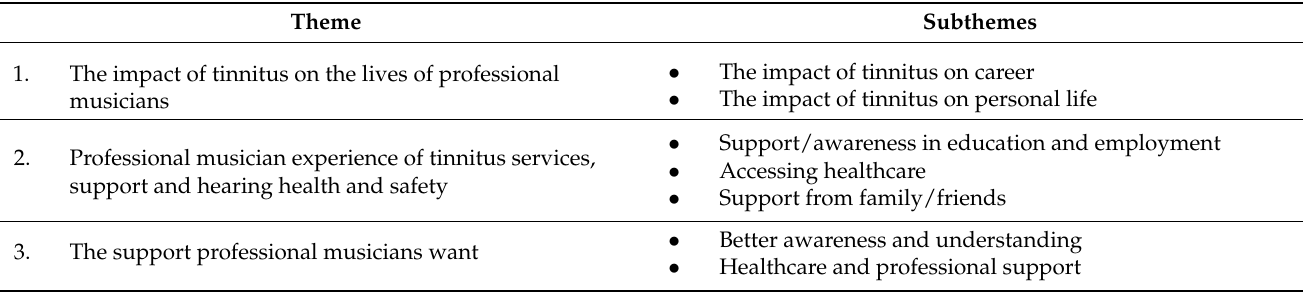
Table 1. Themes reflecting the lived experience of professional musicians who have